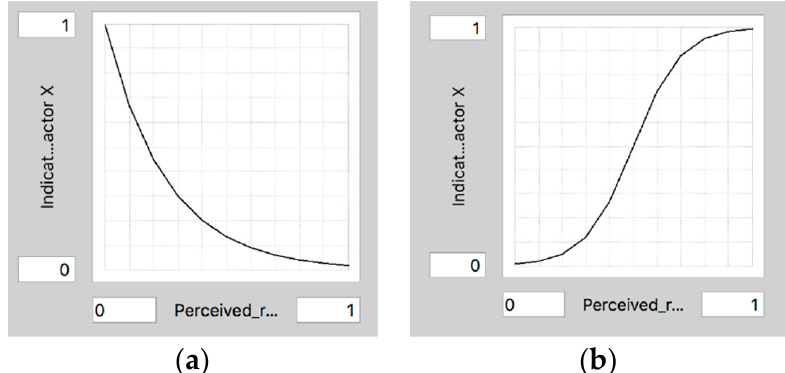
Figure 8. Effect of perceived relative change in a factor (the values on x-axis) on the indicated probability of investing in energy efficiency (the values on y-axis): ( a ) additional payment for energy efficiency measures added to the monthly housing management fee, ( b ) other factors. The graphs were taken as print-screens from STELLA ARCHITECT to present an approach for how the effects of relative changes in the factors are represented as changes in the probabilities to invest in energy efficiency.